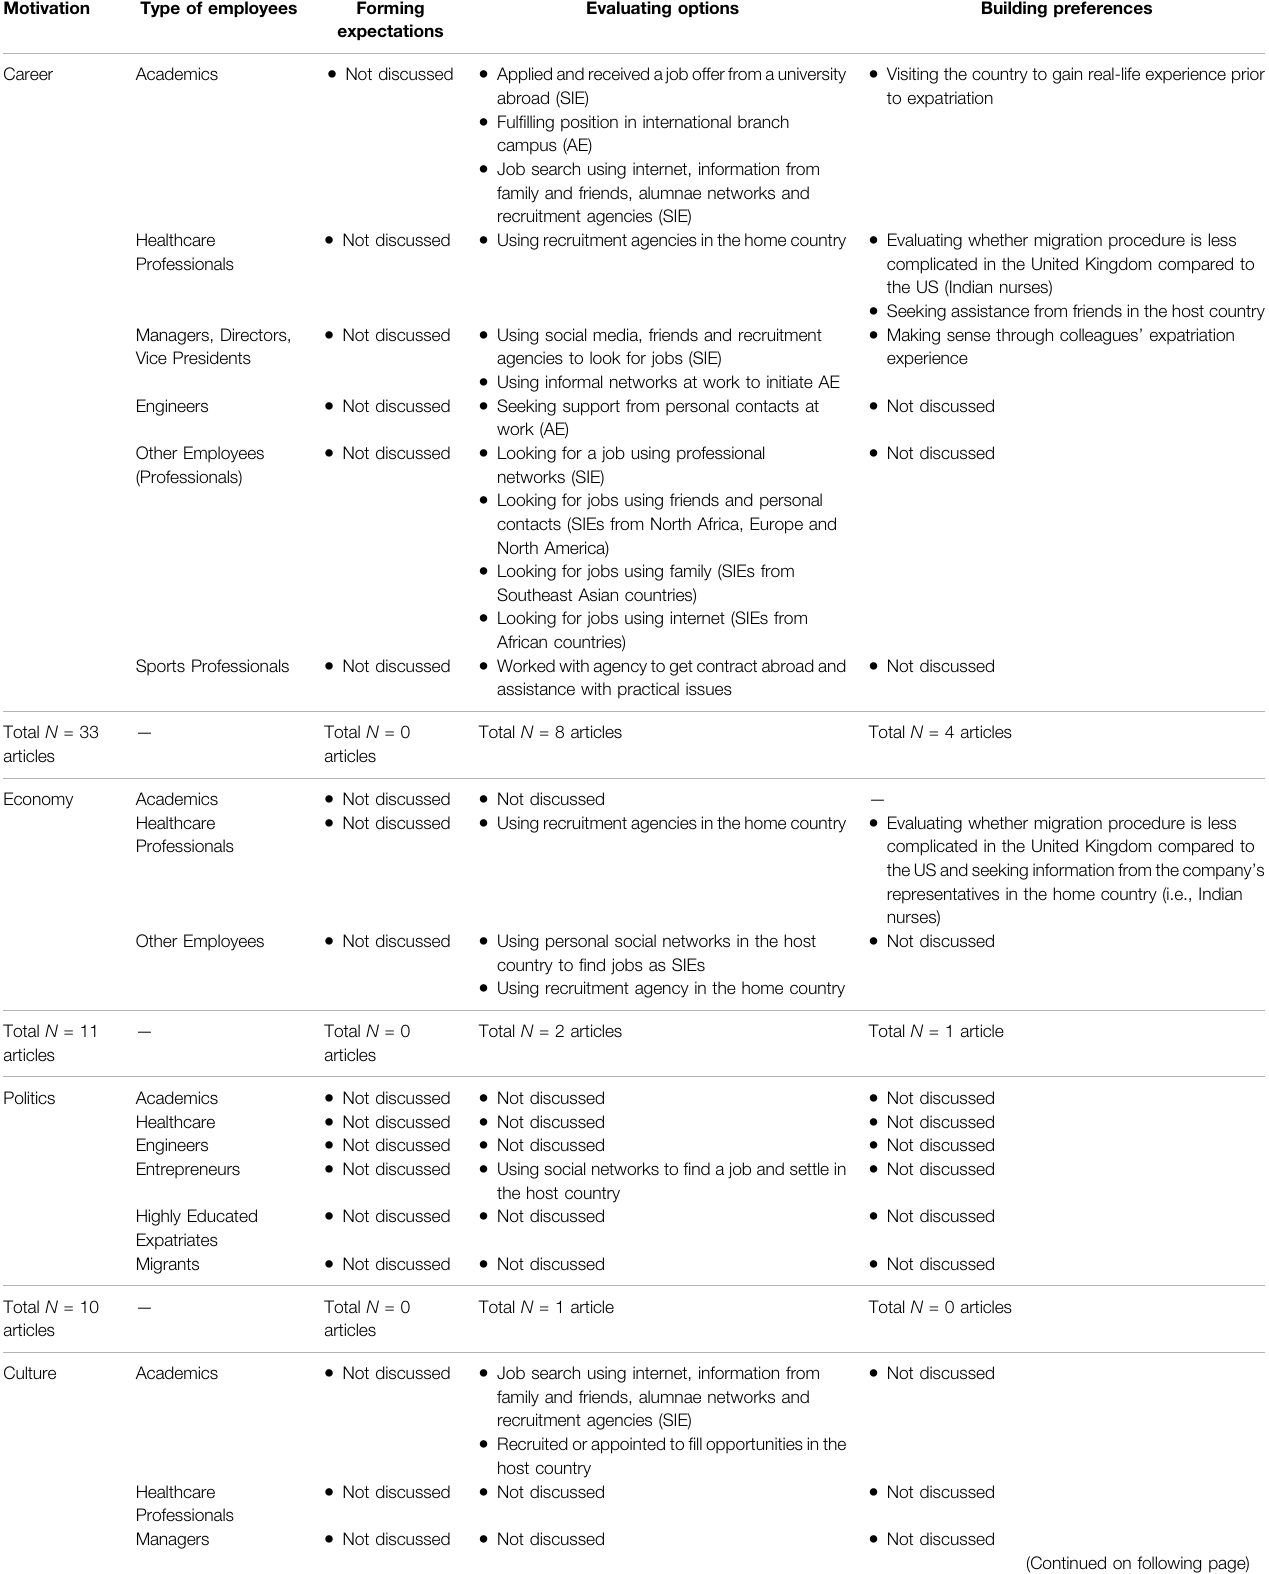
TABLE 3 | An overview of the active role of different types of employees during the motivation process for all four